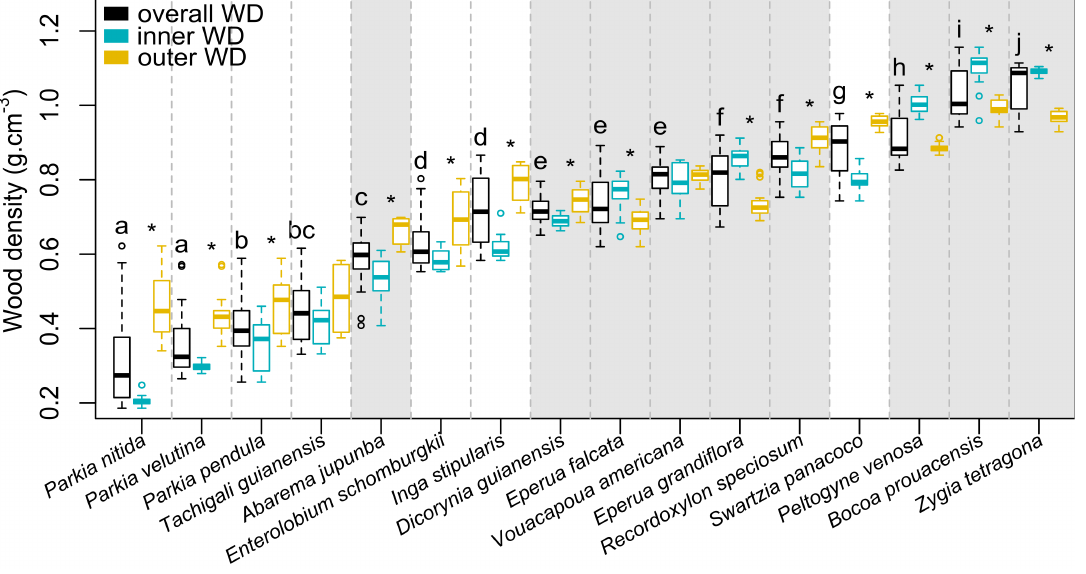
Figure 2. Overall, inner and outer WD distributions of the 16 species under study. Gray vertical bands underline species with heartwood. Species are ordered according to the median value of their overall WD distribution that differ significantly (F 15,939 = 699.26, p < 0.001). Letters correspond to the groups after the post-hoc Tukey range test. Stars (*) indicate significant within-species differences between inn WD and out WD at α <